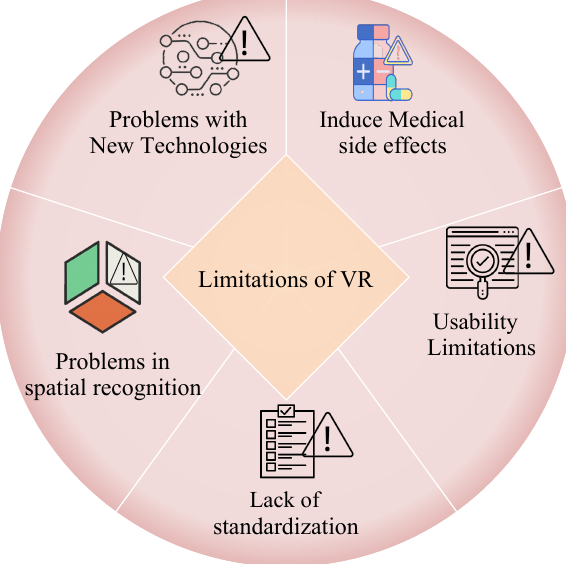
Figure 9. Top limitations of VR